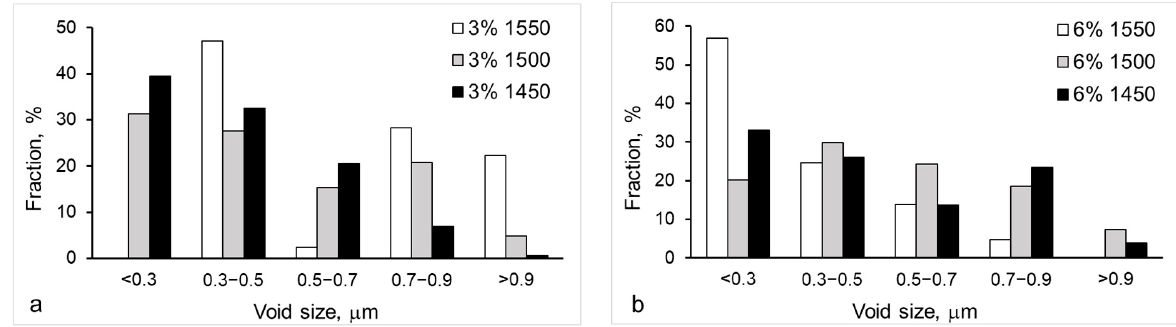
Figure 9. Size distributions of fracture voids for ( a ) 3YSZ and ( b ) 6YSZ ceramics sintered at three temperatures.